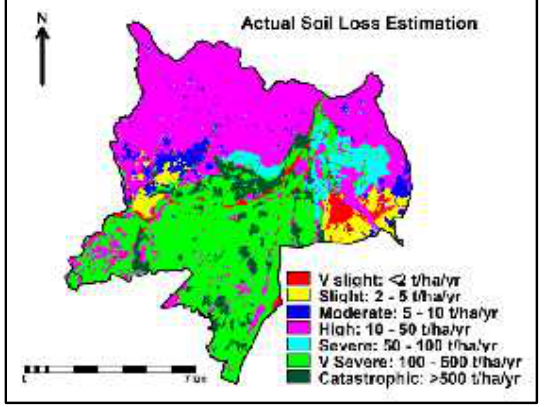
Figure 4. Actual soil loss estimation